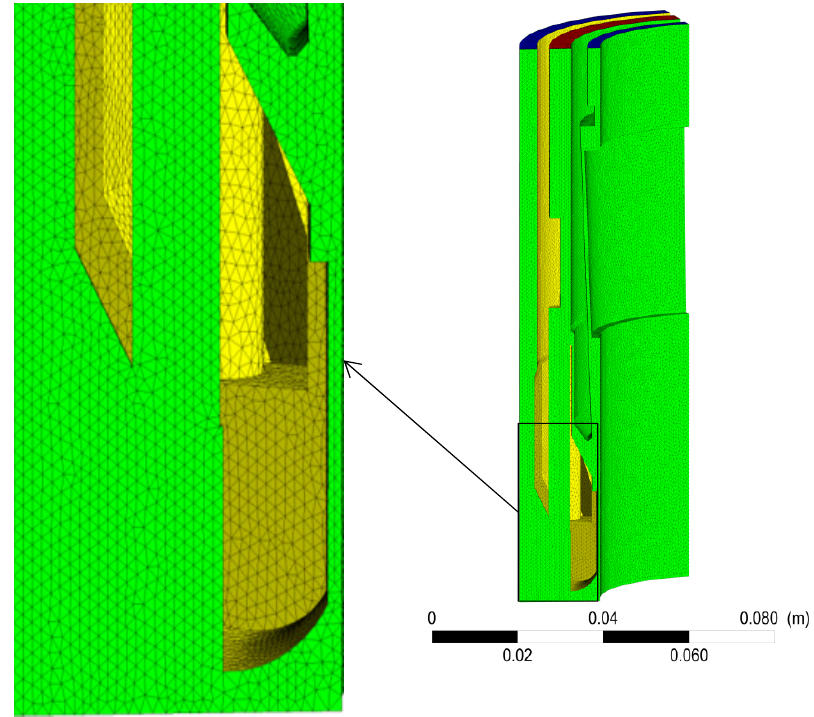
Figure 5. Octree algorithm generates grid model